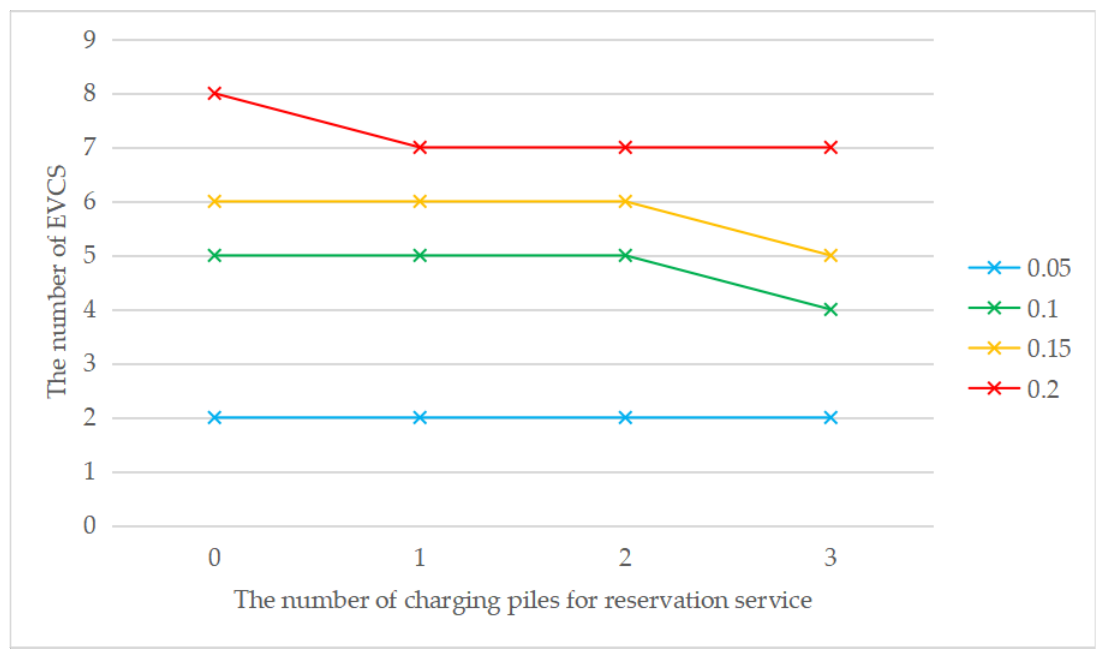
Figure 6. The number of EVCS with changing the number of charging piles for the reservation service under different penetration rates.